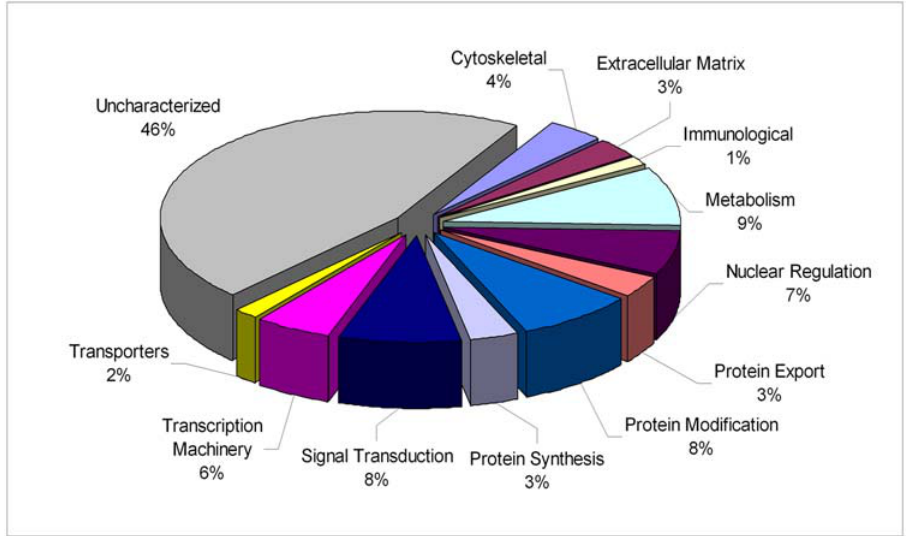
Figure 2. Functional profiles of Brugiamalayi ES proteins. Pie-chart representing the percentage of proteins identified from each of the stages, plotted based on their functional classification. Only a single annotation was assigned to a given protein. All unknown and hypothetical proteins have been classified as uncharacterized. Note: Metabolism includes amino acid, carbohydrate, nuclear and energy metabolism. A complete list is given with additional annotation and embedded links in the Final Secretome-Web (http://exon.niaid.nih.gov/transcriptome/Bm-secretome/Brugia- Secretome-Web.zip) version. AMES : Adult male ES; AFES : Adult female ES; MFES : Microfilariae ES; L3-ES: L3 larval ES; L3-MES:L3 larval molting ES.